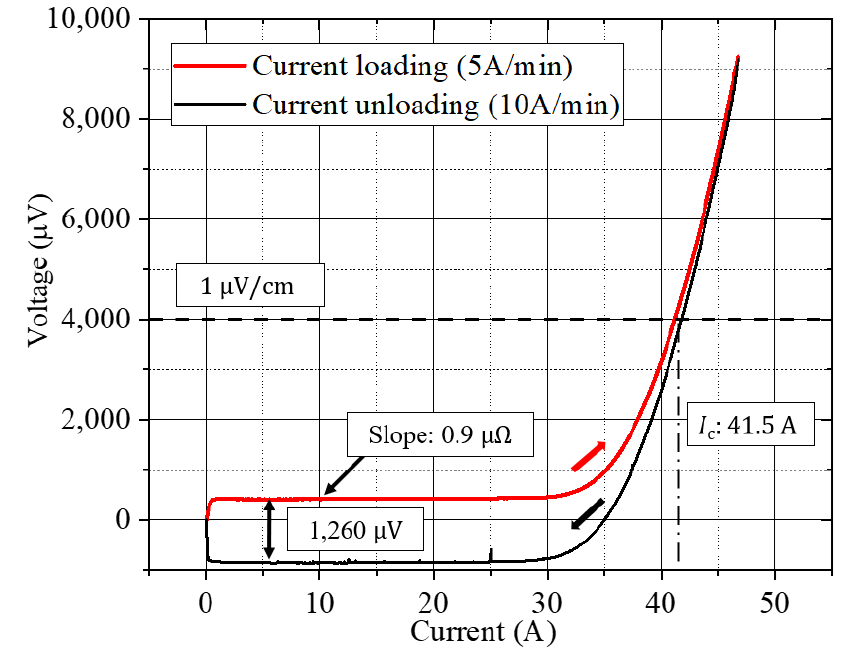
Figure 8. The transport test result of one double pancake of Coil 1. Current in double pancake was loaded at the speed of 5 A/min and unloaded at 10 A/min.